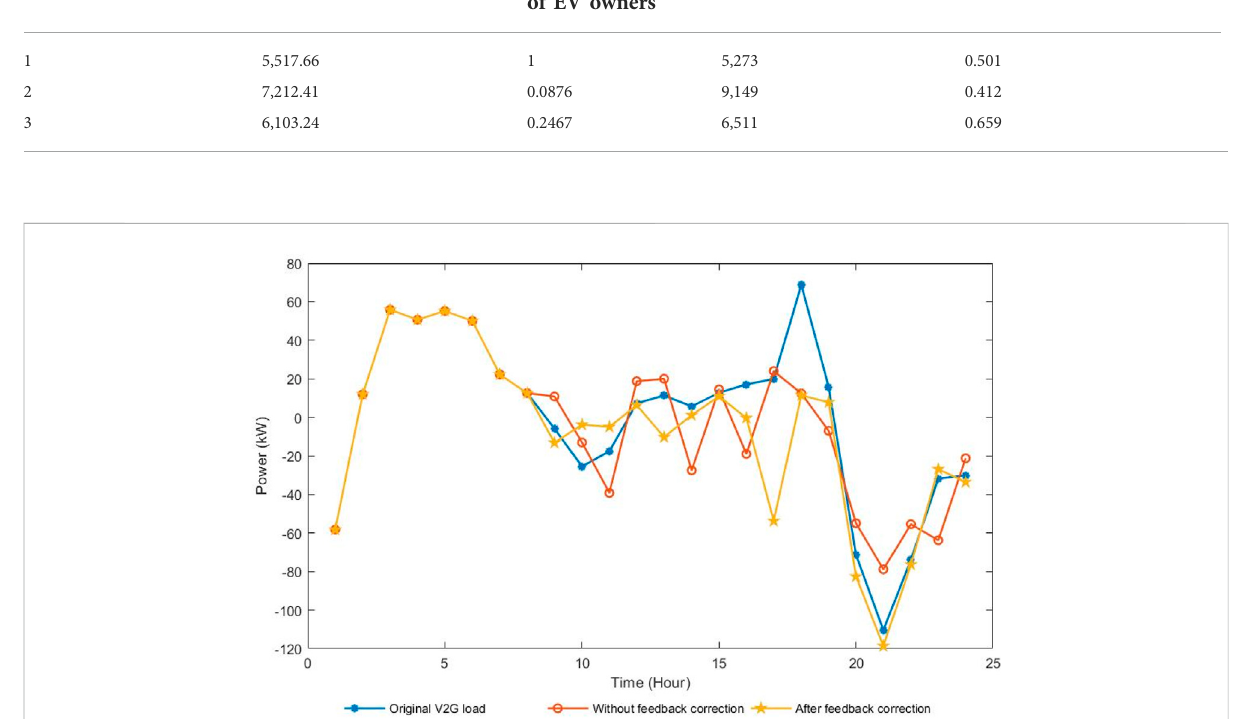
FIGURE 8 Comparison of V2G equivalent load before and after running V2G load feedback correction